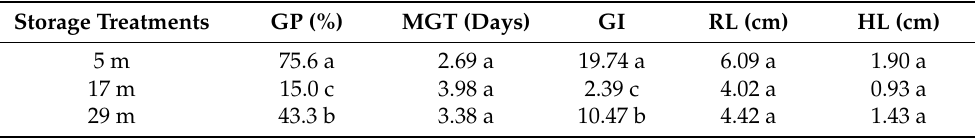
Table 3. Effects of milk thistle populations (Palaionterveno, Mesopotamia, and Spata) on seeds’ germination percentage (GP), mean germination time (MGT), germination index (GI), radicle length (RL), and hypocotyl length (HL) at 20 ◦ C. Seeds were stored for 5 months at room temperature. Populations GP (%) MGT (Days) GI RL (cm) HL (cm) Palaionterveno 73.3 a 2.51 a 19.70 a 5.24 a 1.96 a Mesopotamia 76.7 a 3.02 a 18.66 a 6.99 a 1.69 a Spata 76.7 a 2.84 a 20.87 a 6.05 a 2.05 a For each column, mean values followed by same letters show no significant differences between the treatments. Table 4. Effects of storage duration and conditions (5, 17, and 29 refer to the months (m) of storage and the conditions that prevailed during storage) on milk thistle seeds’ germination percentage (GP), mean germination time (MGT), germination index (GI), radicle length (RL), and hypocotyl length (HL) at 20 ◦ C (mean values of three populations). Storage Treatments GP (%) MGT (Days) GI RL (cm) HL (cm) 5 m 75.6 a 1.43 a For each column, mean values followed by same letters show no significant differences between the